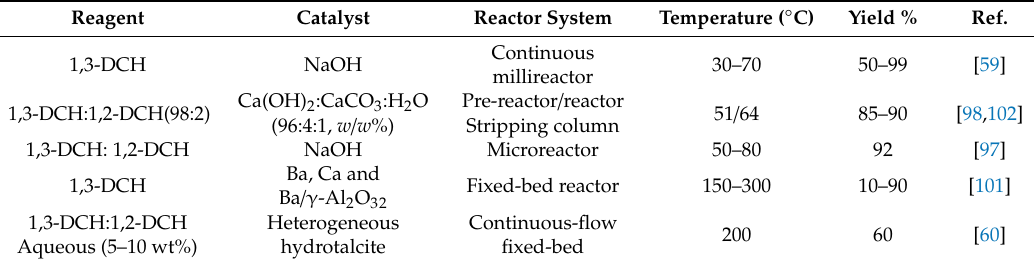
Table 3. ECH synthesis using basic catalysts.